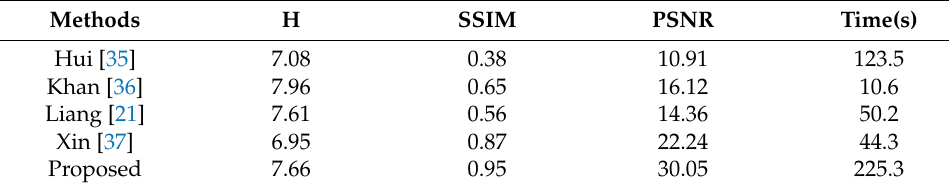
Table 1. Objective values of the images shown in Figure 4.